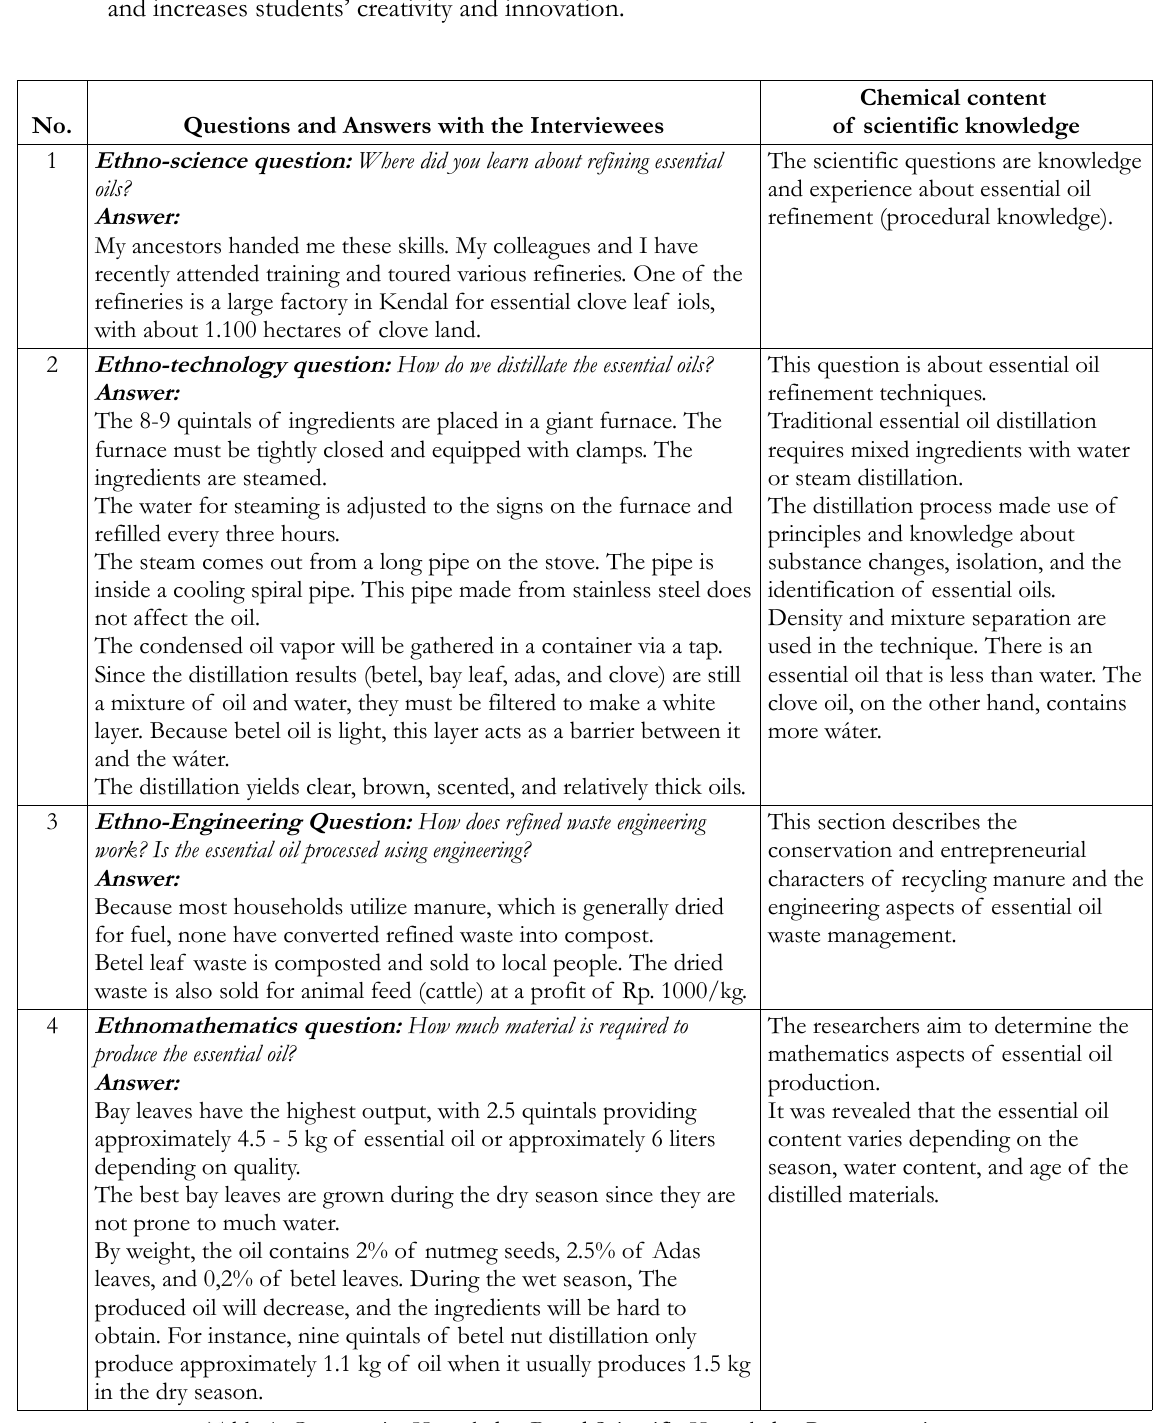
Table 1. Community Knowledge-Based Scientific Knowledge